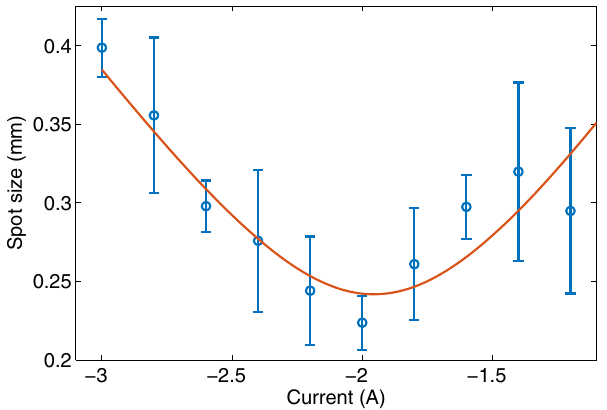
FIG. 4. Fit of the quadrupole scan for the emittance measure- ment of the PWFA beam. Each point is the rms value of the vertical beam size, taken over ten shots.